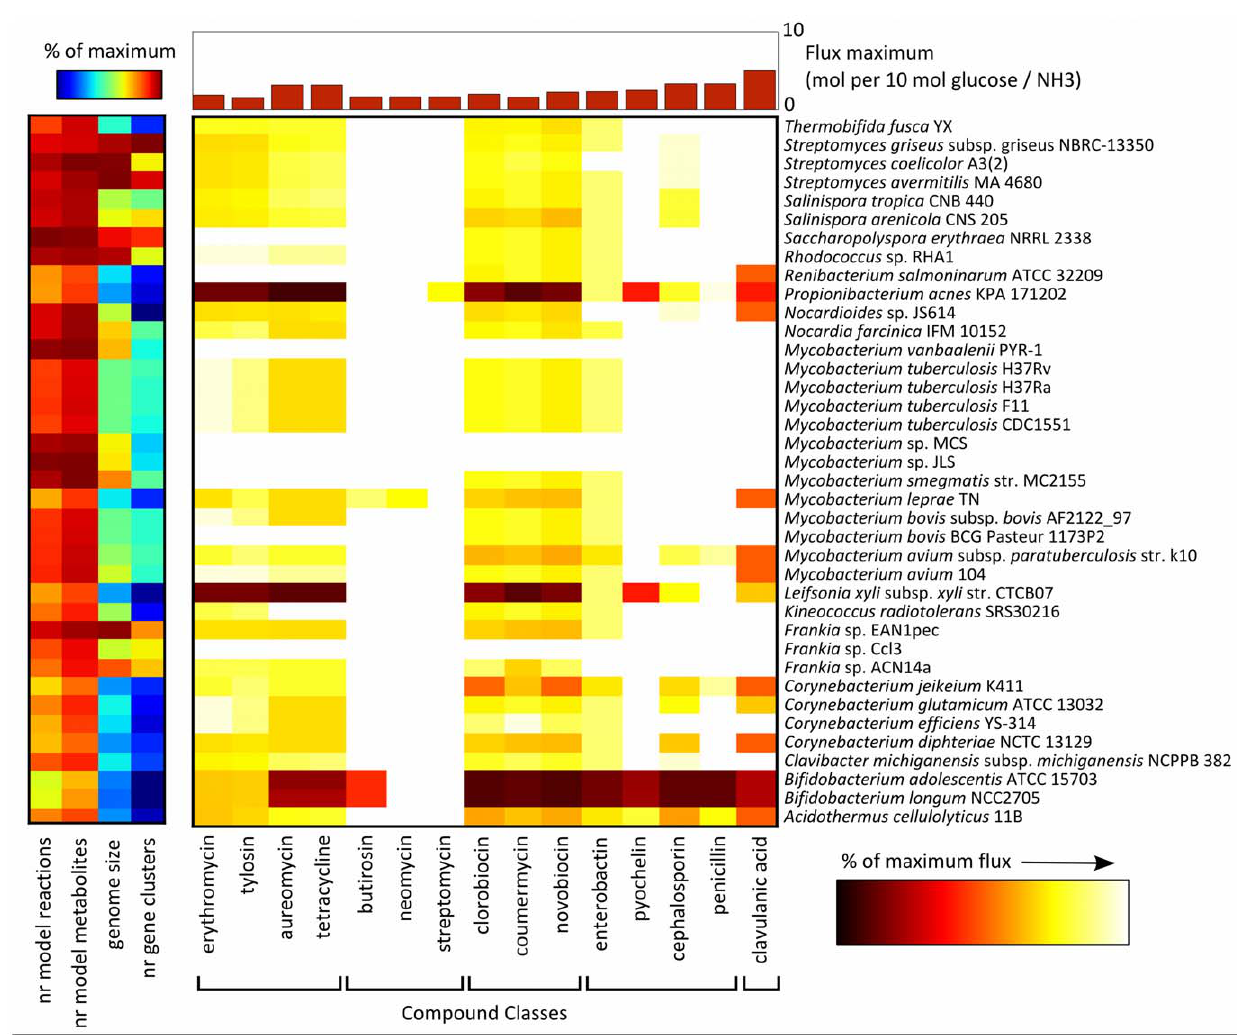
Figure 3. Theoretical maximum fluxes of secondary metabolite production. The heat map shows relative maximal fluxes of the final biosynthetic step in the metabolic pathways leading 15 different secondary metabolites, which were incorporated into the genome-scale metabolic models of 41 actinobacteria. Flux balance analysis was performed on the minimal medium described by Alam et al. [17]. White indicates a high relative flux level, red indicates a low relative flux level (as % of the maximally obtained value across all species, displayed at the top of the figure). In the heatmap on the left, the number of model reactions and metabolites, the genome sizes and the number of secondary metabolite biosynthesis gene clusters (predicted using antiSMASH [54]) are plotted.